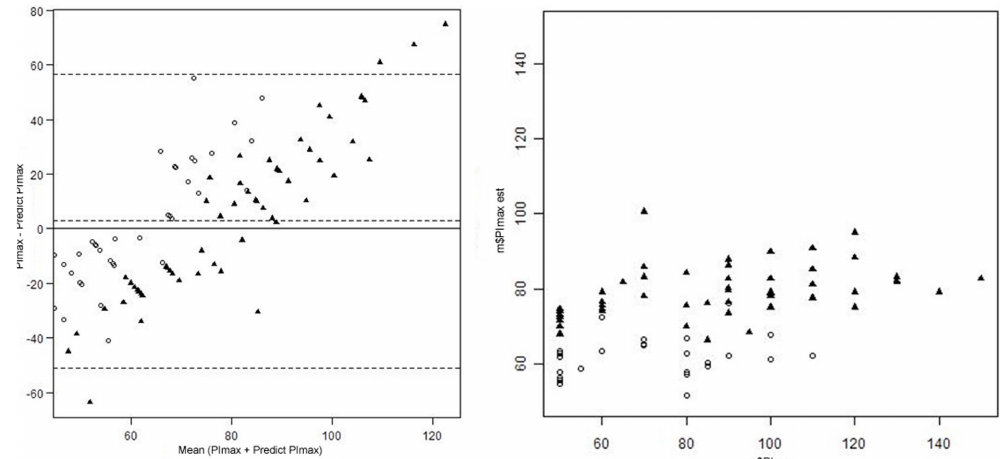
Fig. 7 - Bland-Altman plot and Lin's concordance coefficient of maximal inspiratory pressure (MIP) values predicted by the proposed new formula. Confidence interval 95% (0.21 – 0.42); Lin coefficient (0.36); o=female and ▲ =male